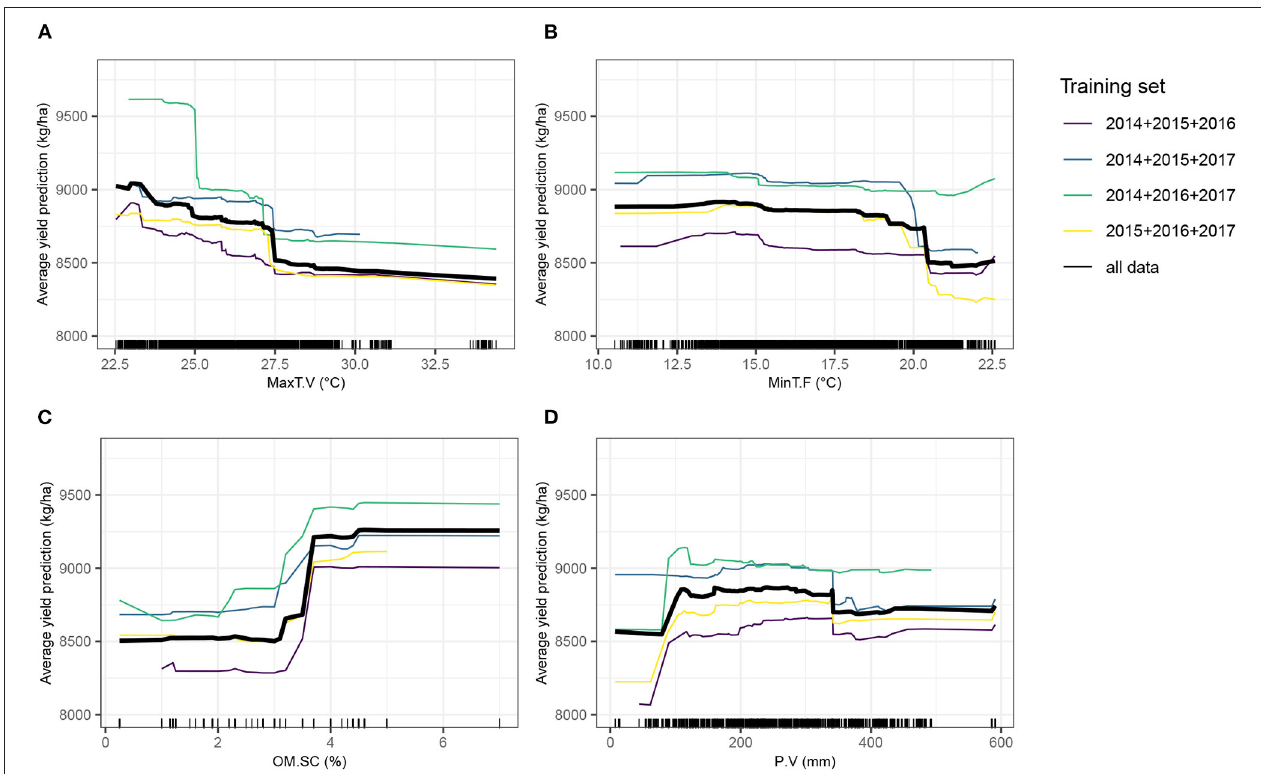
FIGURE 7 | Partial dependence plots (PDPs) showing the behavior of the expected value of predicted yield as a function of four top-ranked predictor variables. The Y-axis value of a PDP is calculated average of all model predictions obtained from the training dataset, when the value of the predictor variable is equal to X. The four training sets from the leave-1-year-out cross-validation scheme (CV0-Year) and the full dataset, separately trained with XGBoost, were used. Tick marks indicate individual observations. (A) MaxT.V, maximum temperature during the vegetative stage; (B) MinT.F, minimum temperature during the flowering stage; (C) OM.SC, percentage of soil organic matter; (D) P.V, Amount of precipitation and irrigation during the vegetative